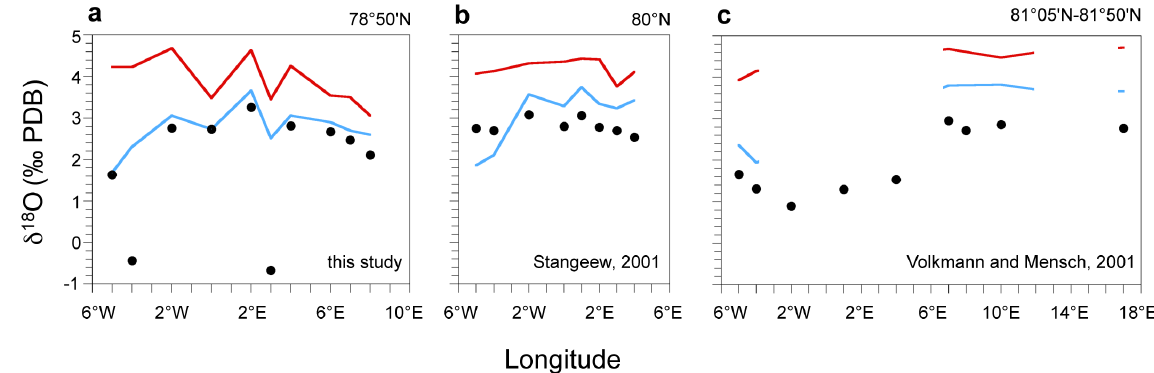
Figure 10. δ 18 O of N. pachyderma from the water column (weighted average; black dots) with the range of equilibrium calcite values in the upper 200m (blue line: minimum, red line: maximum) along three parallel E–W transects between 78 (a) this study, (b) Stangeew, 2001; Bauch (unpublished data), (c) Volkmann and Mensch,